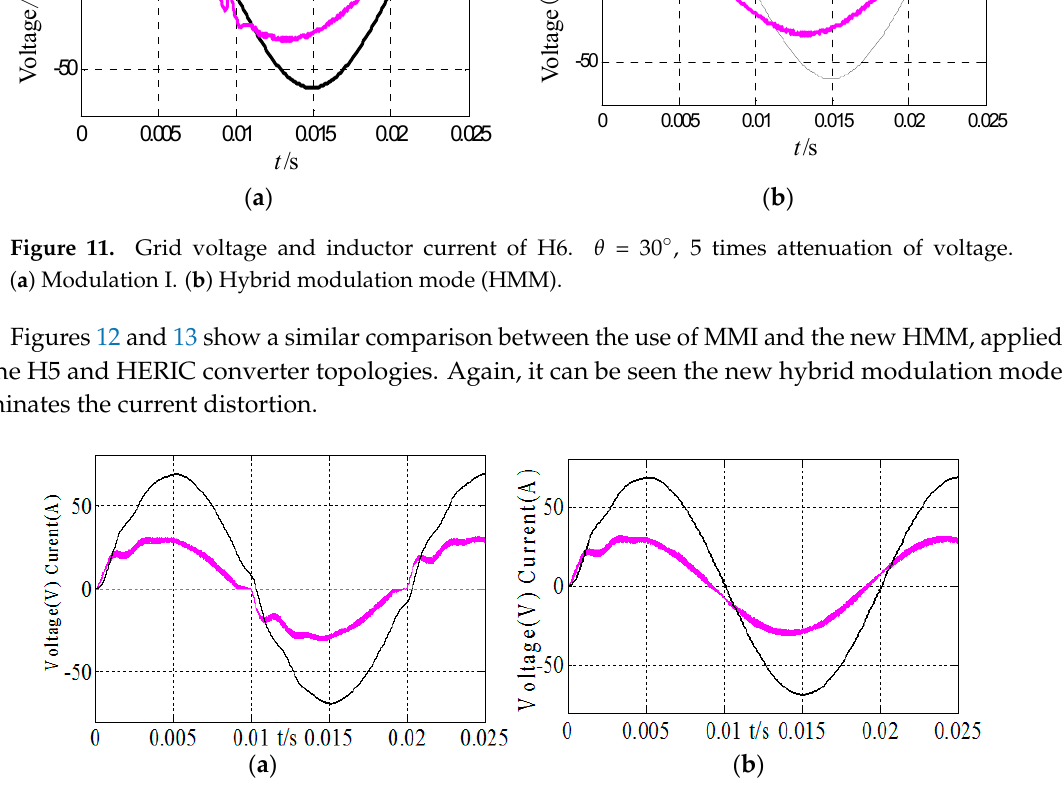
Figure 13. Grid voltage and inductor current of HEIRC. θ = 30°, 5 times attenuation of the voltage. ( a ) Modulation I. ( b ) Hybrid modulation mode (HMM).